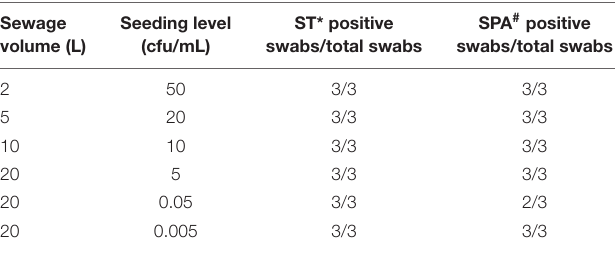
TABLE 2 | Limit of detection of Moore swab method for recovering ST and SPA seeded into different volumes of sewage samples.